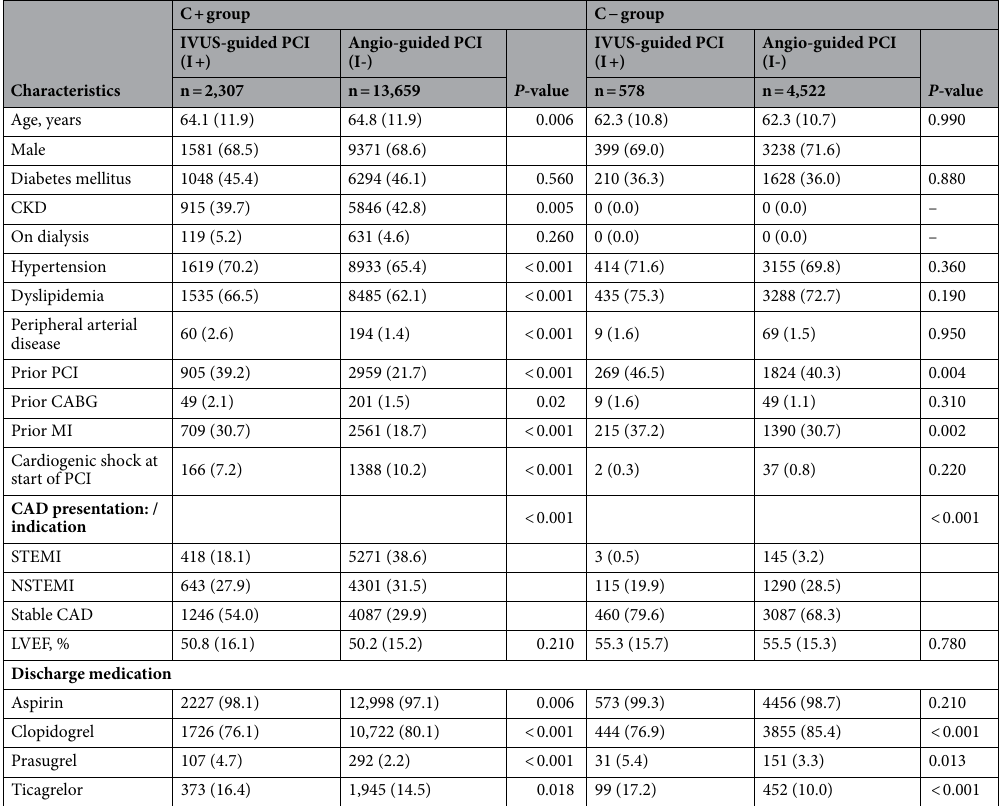
Table 1. Baseline patient characteristics. Values are expressed as n (%) or mean ± SD. Abbreviations: C + , met criteria; C−, unmet criteria; CABG, coronary artery bypass graft; CAD, coronary artery disease; CKD, chronic kidney disease; IVUS, intravascular ultrasound; I + , IVUS-guided PCI, I−, angio-guided PCI; LVEF, left ventricular ejection fraction; MI, myocardial infarction; NSTEMI, non-ST segment elevation myocardial infarction; PCI, percutaneous coronary intervention; STEMI, ST segment elevation myocardial